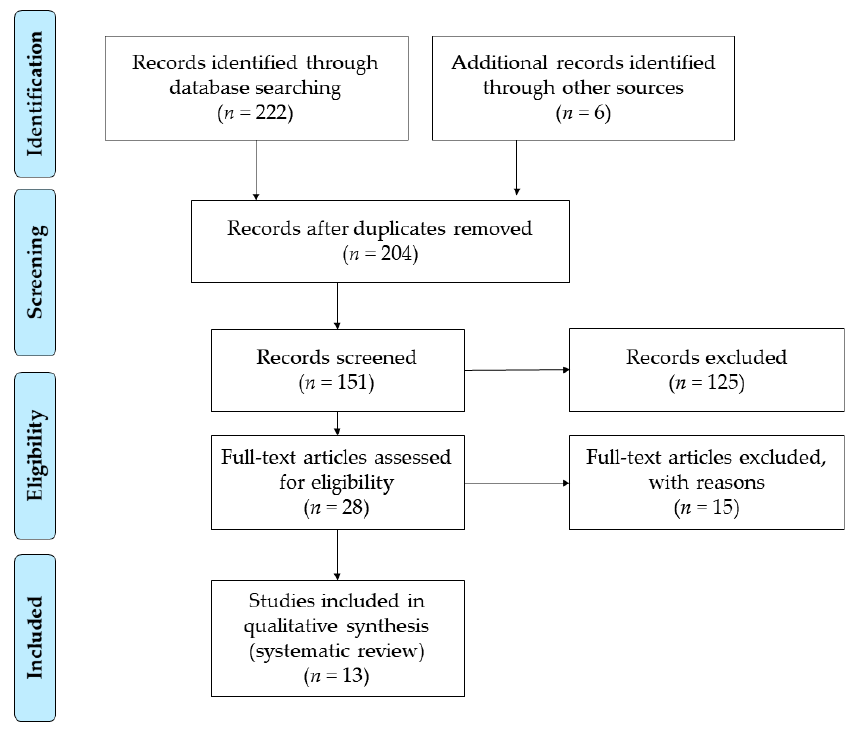
Figure 1. Flow diagram.